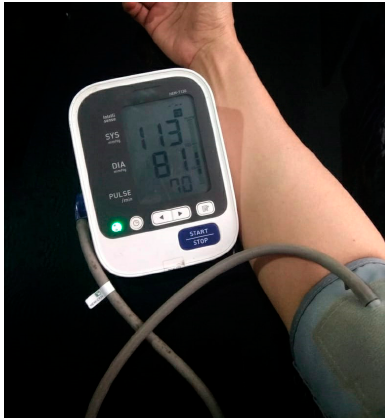
Figure 1. Traditional blood pressure measurement device.